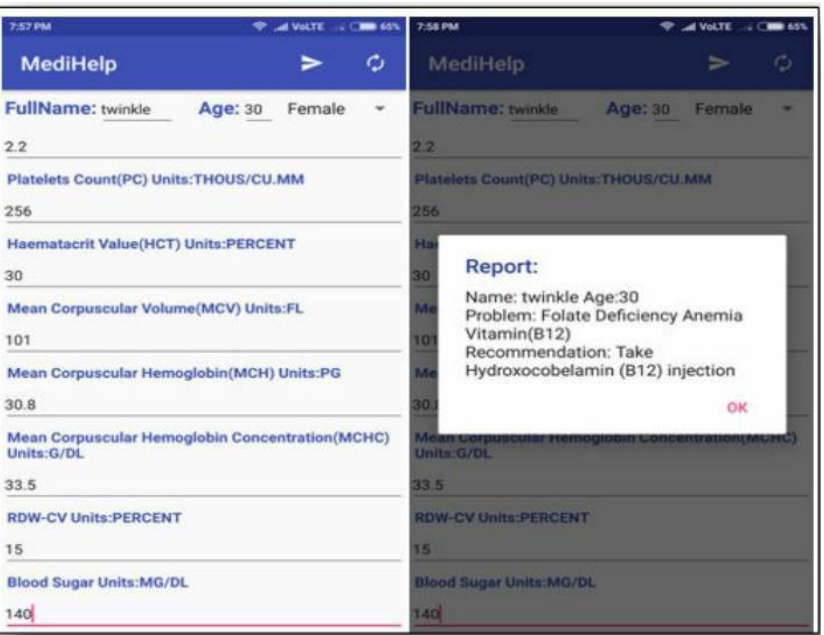
Figure 8. User interface with details of the third person.